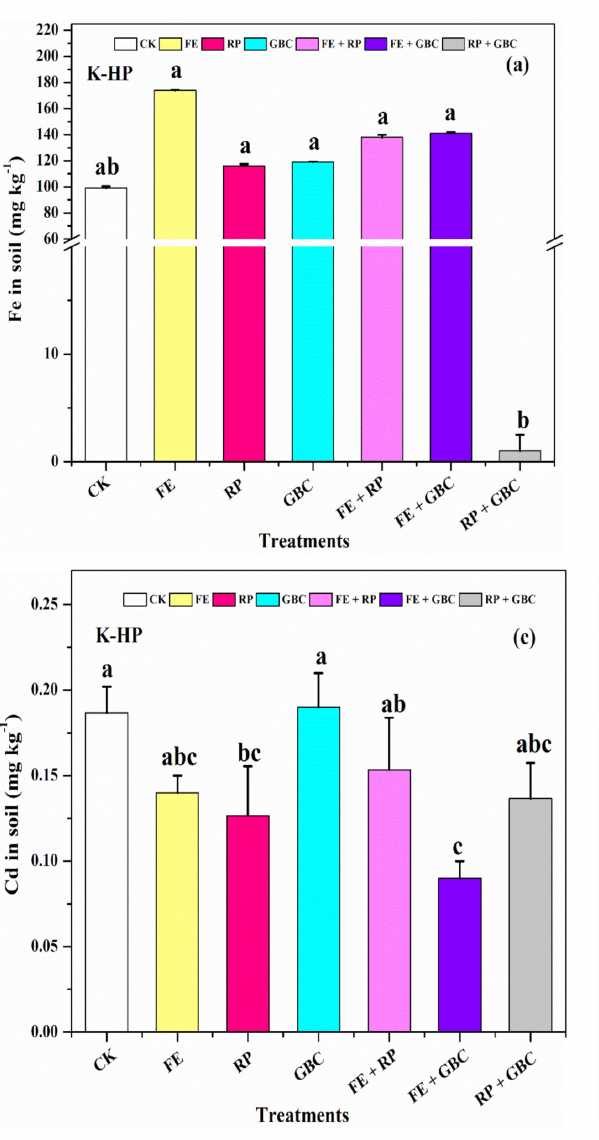
Figure 6. Influence of additives on Fe in ( a ) in K-HP soil and ( b ) H-LP soil; influence of additives on Cd, ( c ) K-HP soil, and ( d ) in H-LP soil. The values in a given column followed by the same letter are statistically not significantly ( p < 0.05) using Tukey’s HSD